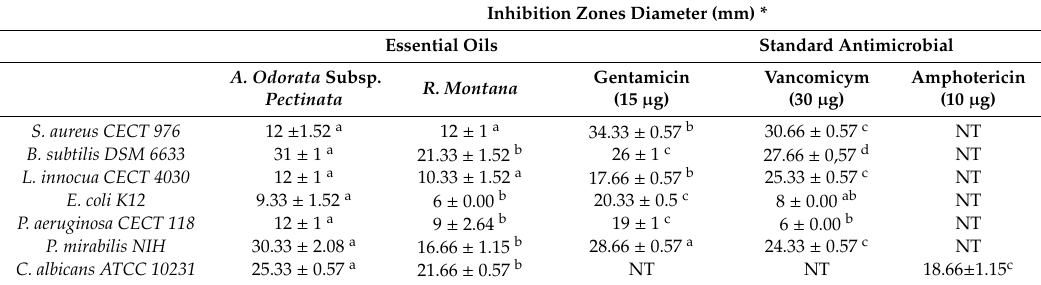
Table 3. Antimicrobial activity of A. odorata subsp. pectinata and R. montana essential oils determined by disc di ff usion